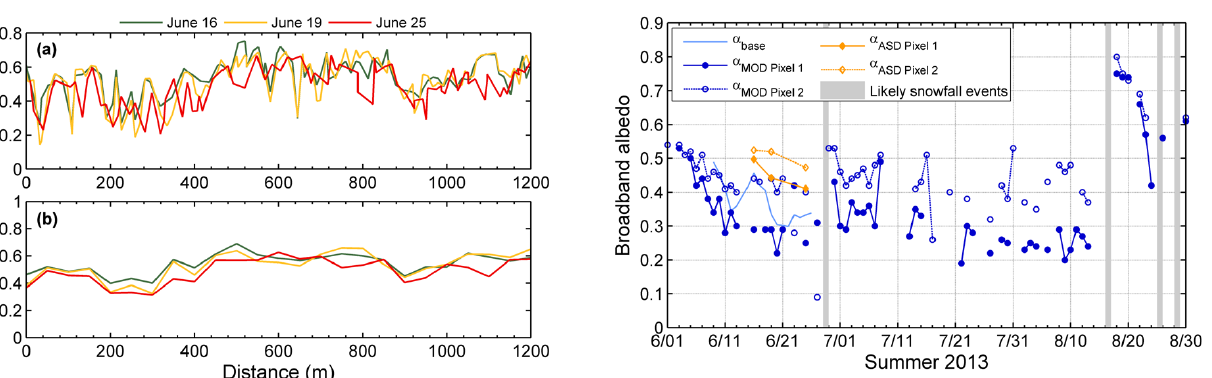
Figure 2. High-quality broadband α ASD observations on 16, 19, and 25 June (a) and broadband α ASD averaged in 50m bins (b) along the length of the transect starting near Site E (0m) and ending near Site A (1200m).